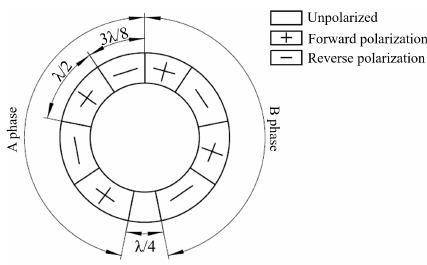
Figure 3. Stator polarization arrangement of the